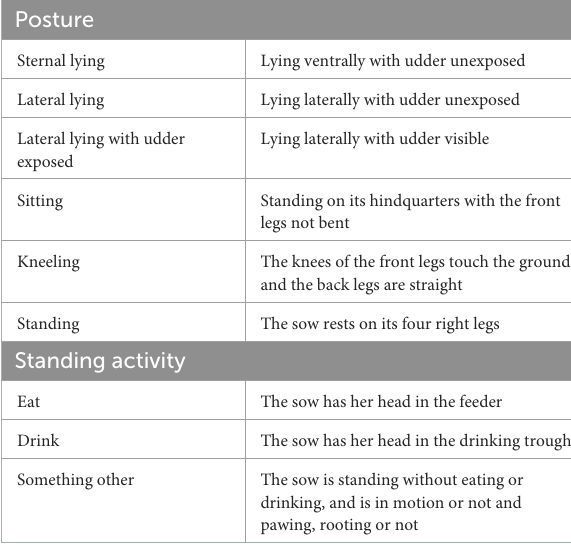
TABLE 1 Ethogram of sow postural activity and standing activity. Posture Sternal lying Lying ventrally with udder unexposed Lateral lying Lying laterally with udder unexposed Lateral lying with udder